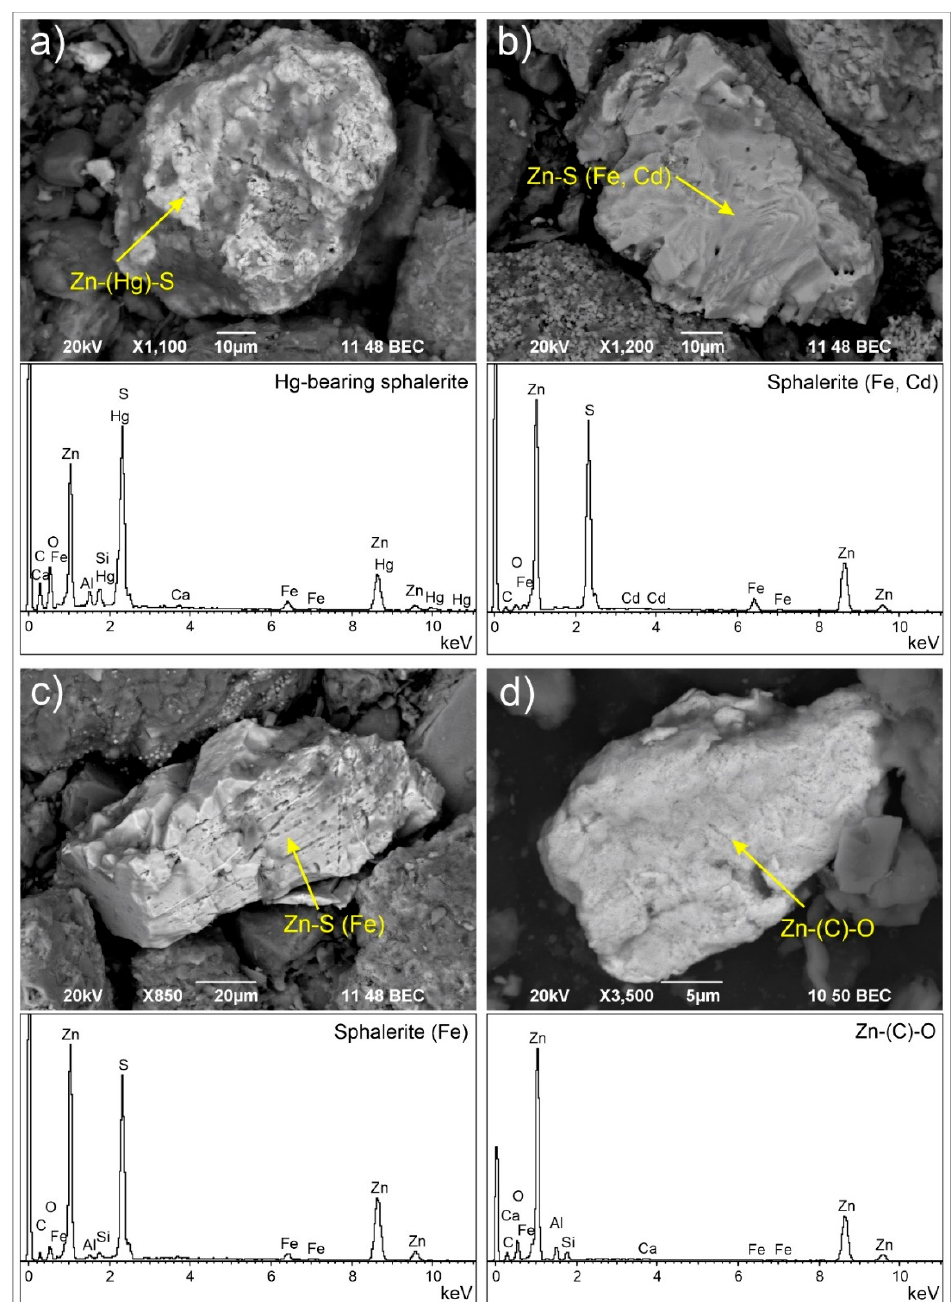
Figure 7. SEM(BSE) images and EDS spectra of solid Zn carriers in stream sediment and mine waste: ( a ) Hg-bearing sphalerite with corroded and pitted surface; ( b ) sphalerite with minor Fe and Cd; ( c ) sphalerite with minor Fe content, corroded along the cleavage; ( d ) Zn-(C)-O phase determined as either smithsonite, zincite or hydrozincite.